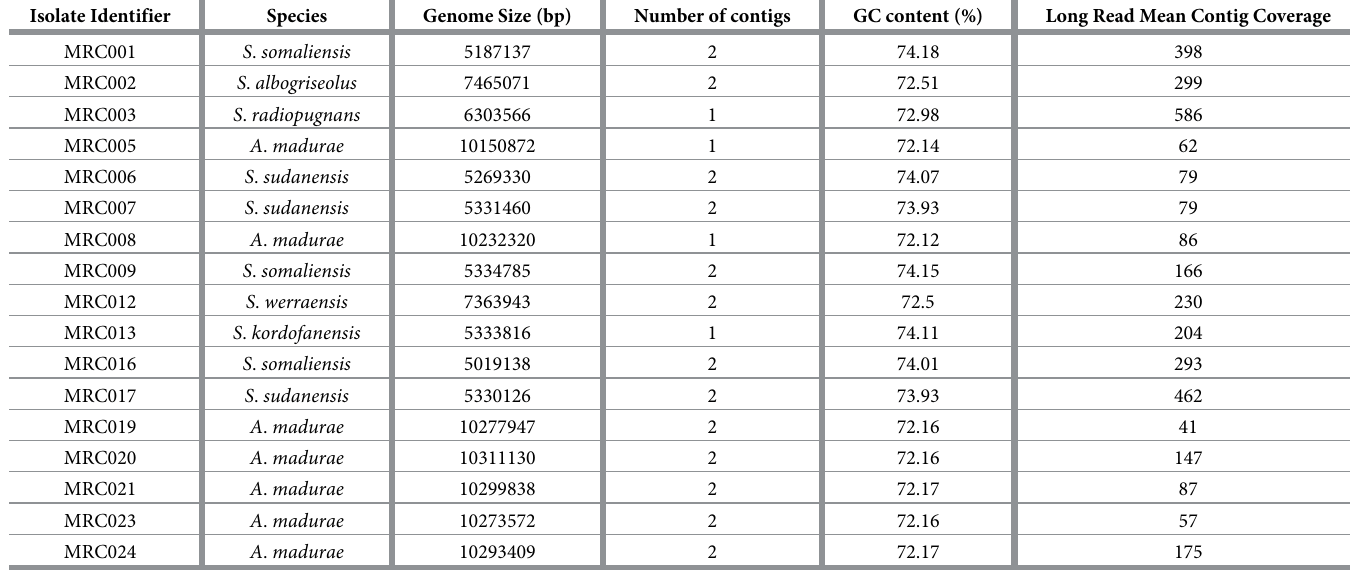
Table 3. Assembly statistics for all isolate genomes sequenced in this project. The genomes from these assemblies are available under NCBI Bioproject PRJNA782605. Isolate Identifier